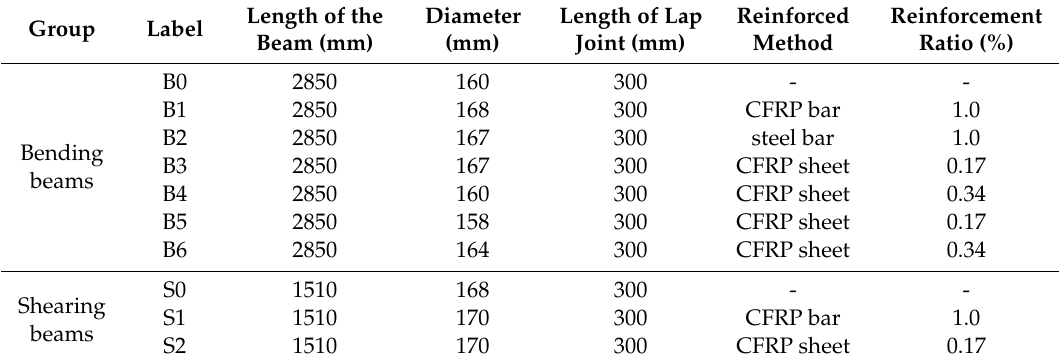
Table 1. Main parameters of test